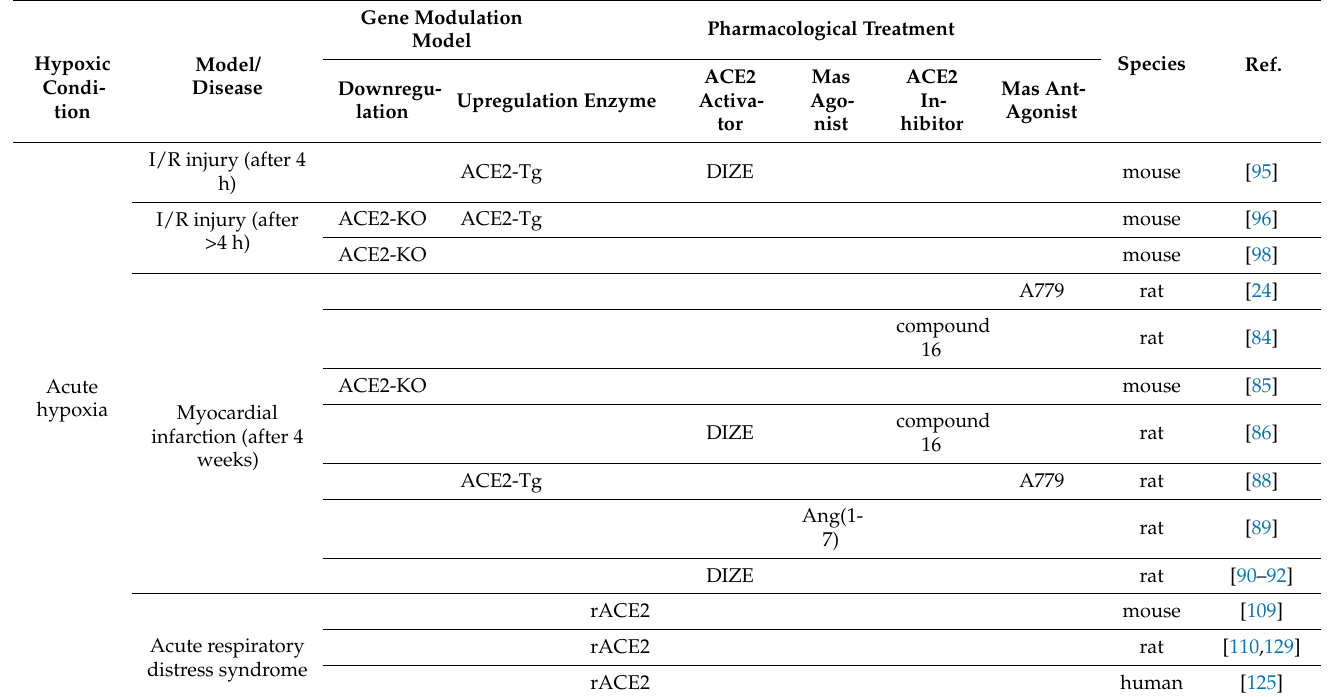
Table 2. Gene modulation and experimental ACE2/Ang(1-7)/Mas pharmacological treatment in hypoxic conditions.